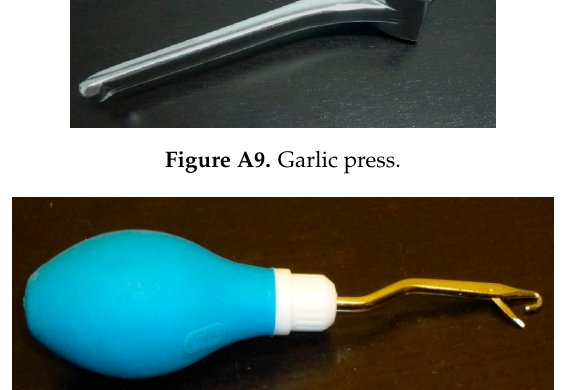
Figure A10. Latch hook tool.